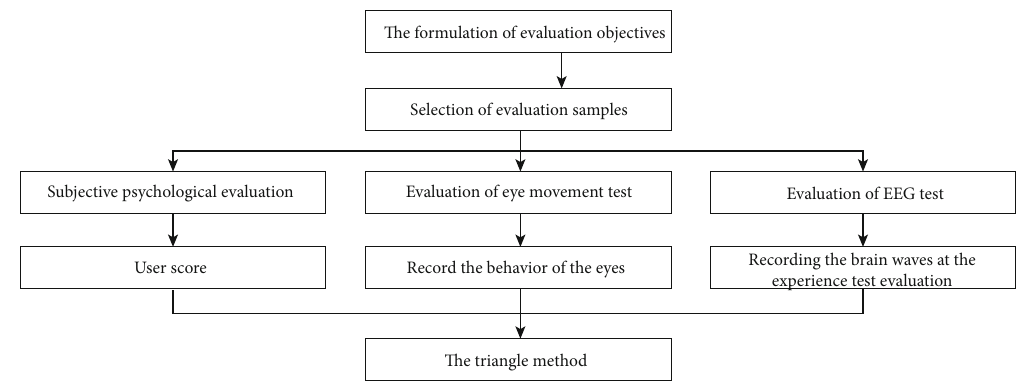
Figure 1: Experimental process of the triangular veri fi cation